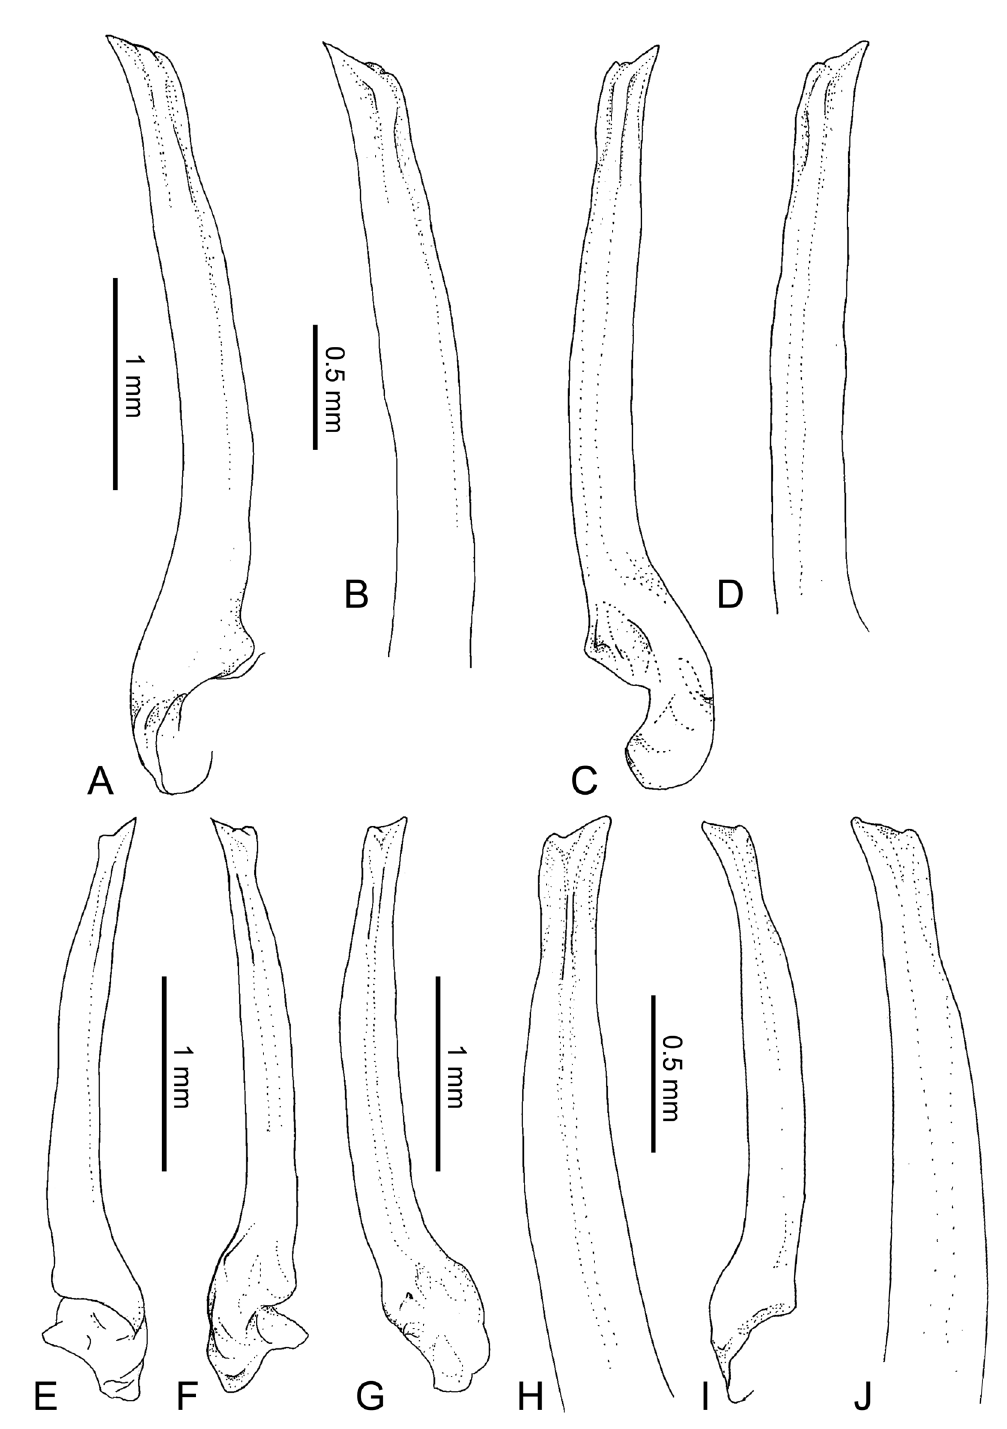
Fig. 11. A–D . Rochinia strangeri Serène & Lohavanijaya, 1973, ♂ (12.1 × 8.0 mm) (ZRC 2016.0546), South China Sea, drawing of left G1. A . Ventral view. B . Ventral view of distal portion. C . Dorsal view. D . Dorsal view of distal portion. E–F . Rochinia kagoshimensis (Rathbun, 1932), holotype, ♂ (11.2 × 6.8 mm) (USNM 48253), off Kagoshima gulf, drawing of left G1. E . Ventral view. F . Dorsal view. G–J . Rochinia kagoshimensis (Rathbun, 1932) comb. nov., ♂ (10.7 × 6.9 mm) (ZRC 2016.0549), South China Sea, drawing of left G1. G . Ventral view. H . Ventral view of distal portion. I . Dorsal view. J . Dorsal view of distal